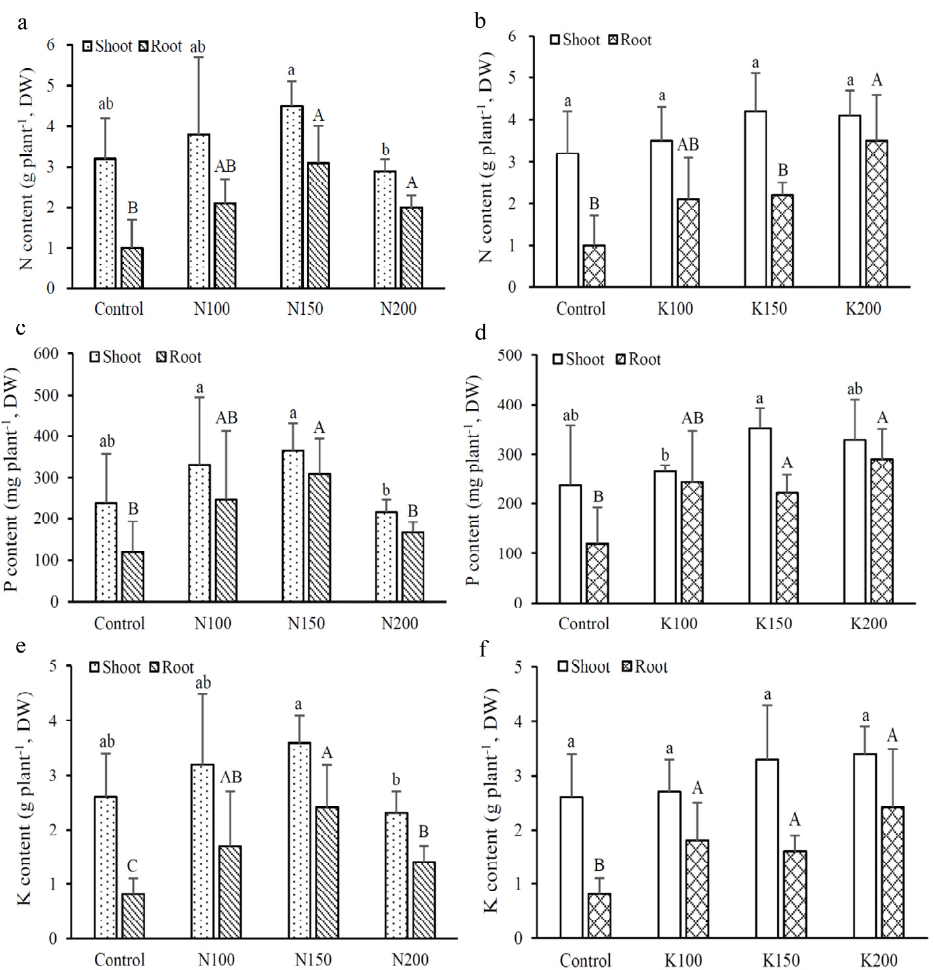
Figure 3. Effects of different fertilizer treatments on total nitrogen, total phosphorus and total potassium contents in shoots and roots of C. taiwanianum : ( a , b ) total nitrogen contents; ( c , d ) total phosphorus contents; ( e , f ) total potassium contents. Values are mean ± standard deviation ( n = 4). The bars with different letters within the same fertilizer treatment (N treatments: Control, N100, N150 and N200; K treatments: Control, K100, K150 and K200) of shoots (lowercase letters) and roots (uppercase letters) are significantly different ( p < 0.05, LSD tests).